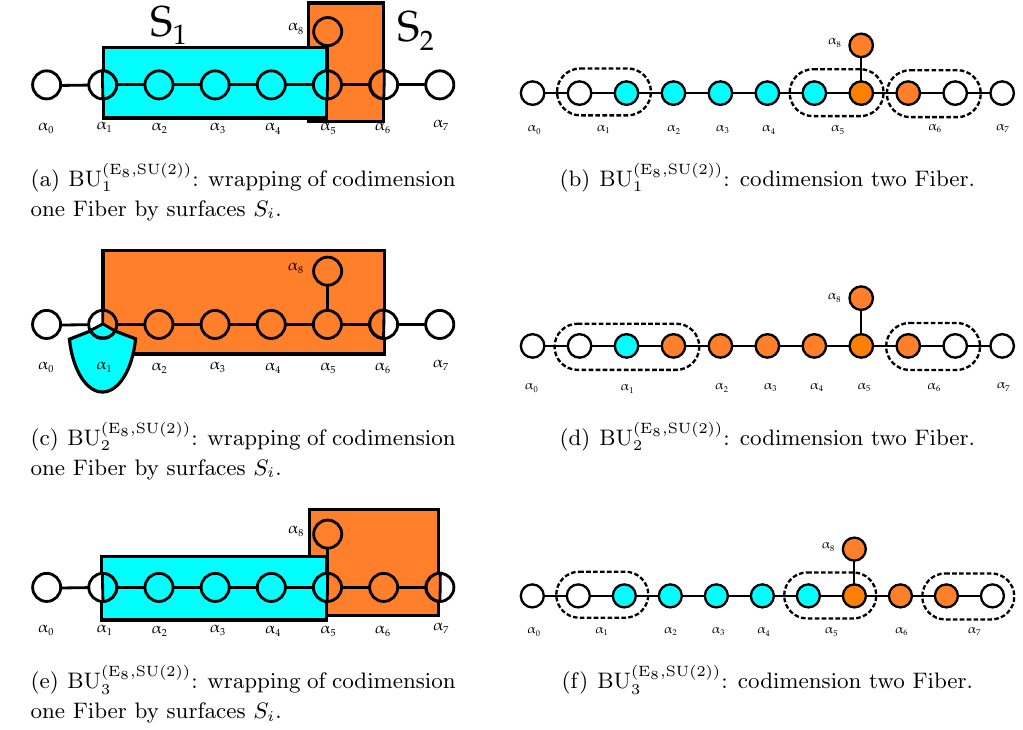
Figure 7 . Example Blowups for the Rank two E-string BU (E 8 ; SU(2)) the E 8 and the curves that are contained in the surfaces components S 1 (turquois) and S 2 (orange) of the non-(cid:13)at (cid:12)ber, as well as, in the second row of each model, the actual codimension two (cid:12)ber with all the irreducible (cid:12)ber components and their